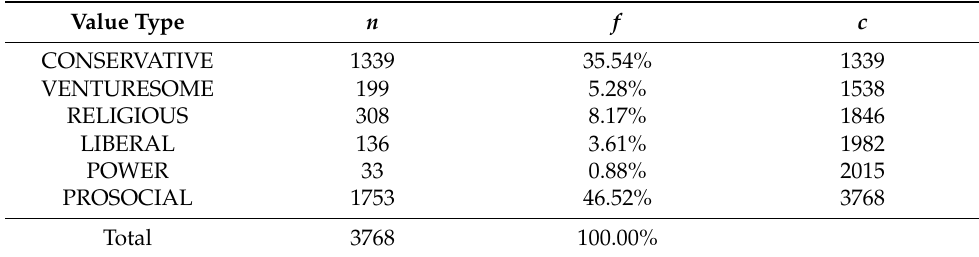
Table 5. Distribution of value types among the Czech